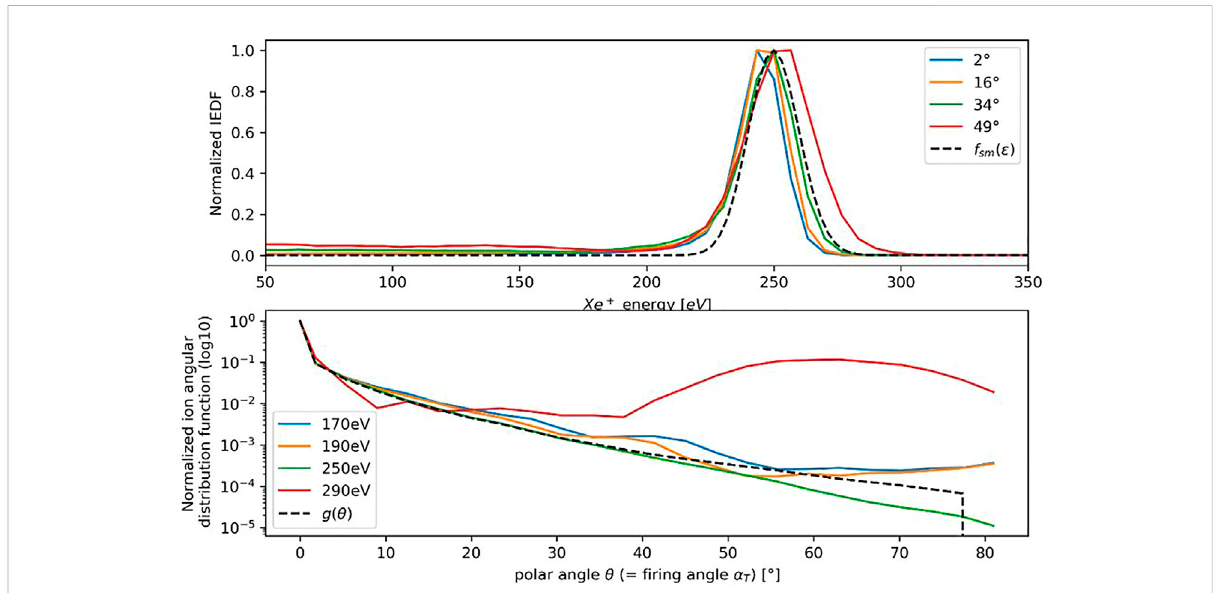
FIGURE 7 Top: normalized velocity distribution for various θ angles. Bottom: normalized angular distribution for various kinetic energies (log10). In black, the f sm ( v r ) and g ( θ ) derived from the hybrid model fi